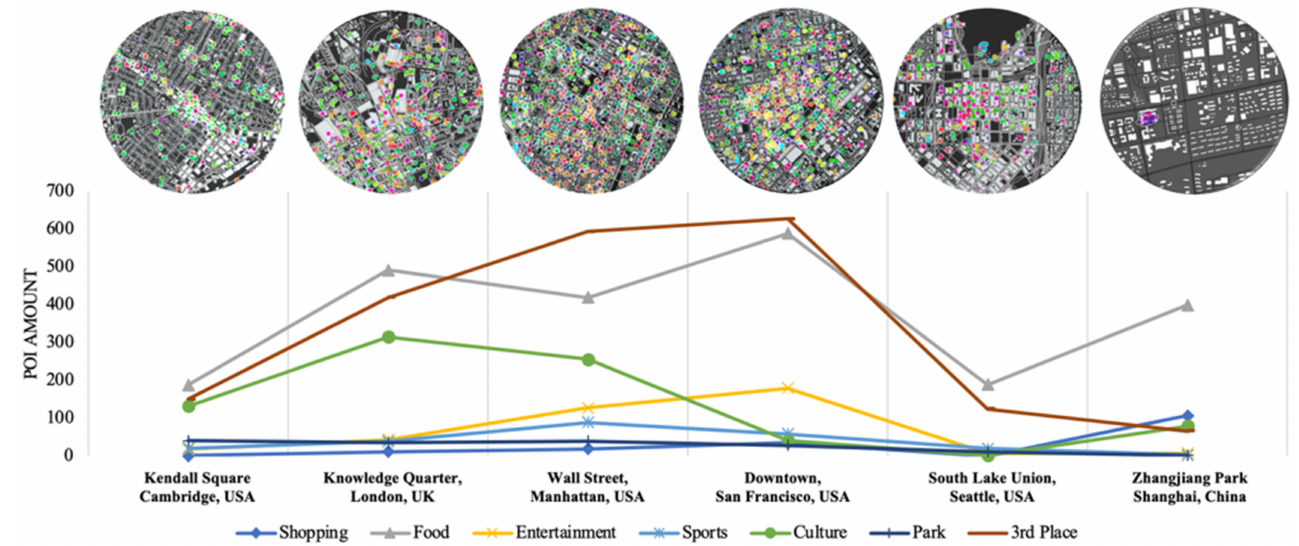
Figure 10. Comparing amounts of urban amenities and services especially the 3rd